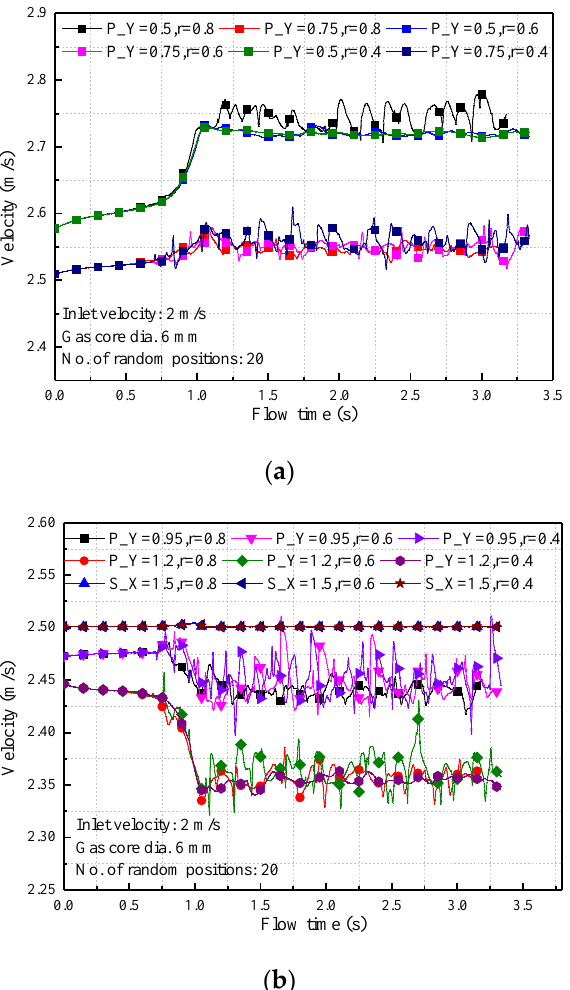
Figure 7. Comparison of velocity fluctuation of the gas–liquid bubbly flow for different central distribution factors, r with given values of 0.4, 0.6 and 0.8. Data were monitored at (x, y) coordinate of ( a ) (1.5, 0.5) for P_Y = 0.5 and (1.5, 0.75) for P_Y = 0.75, ( b ) (1.5, 0.95) for P_Y = 0.95, (1.5, 1.2) for P_Y = 1.2, and S_X = 1.5 presents the surface-averaged velocity of bubble – liquid flow.